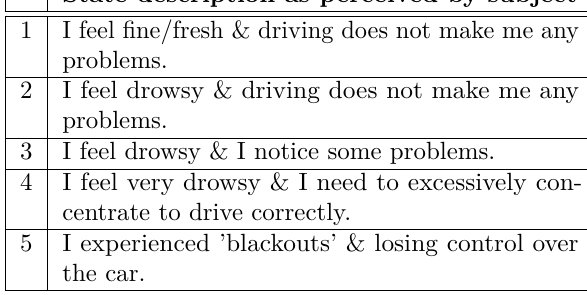
Table 1. Self-rating sleepiness scale developed at faculty of Transportation Sciences, CTU in